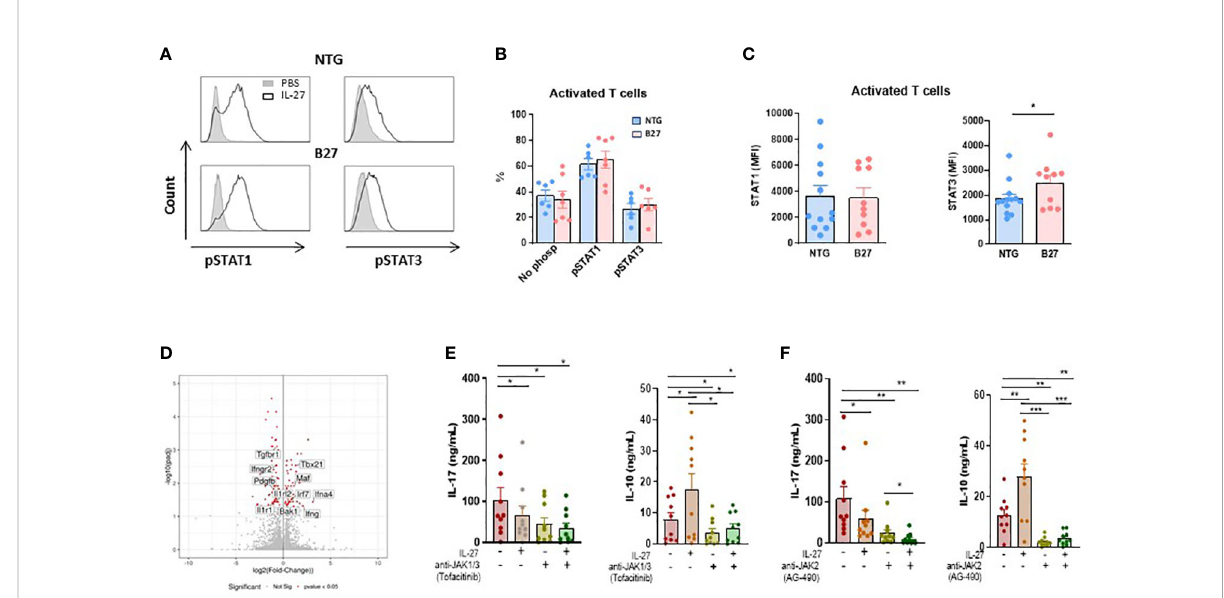
FIGURE 3 JAK-STAT signaling is involved in IL-27 modulatory effect. (A) Representative histogram of mesenteric LN cells stimulated by IL-27 and stained intracellularly for phosphorylated STAT1 and STAT3 gated on CD4 + CD25 + activated T cells. (B) The percentage of pSTAT1 and pSTAT3 was analyzed in gated CD4 + CD25 + activated T cells from mesenteric LN of NTG and B27-rat aged of 4-5 months. (C) STAT1 and STAT3 levels were analyzed by fl ow cytometry in gated CD4 + CD25 + activated T cells from mesenteric LN of NTG and B27 rat. Values are the mean + SEM of 6-13 rats/group. *p<0.05. (D) Volcano plot representing the results of RNAseq analysis of differentiated Th 17 cells in the presence of IL-27, as compared to medium control. The data for all genes are represented by log2 (fold change) vs. log10 of adjusted p-value. The signi fi cative different genes are highlighted in red. Values represent results from 5 rats/group. (E, F) IL-17 and IL-10 levels were determined by ELISA in supernatants from CD4 + CD25 + activated T cells after 3 days of stimulation with coated anti-CD3 in the presence of IL-27 and/or anti-JAK1/3- tofacitinib (E) and/or anti-JAK2-AG490 (F) . Values are the mean + SEM of 10 rats/group. *p < 0.05; **p = 0.001; ***p =